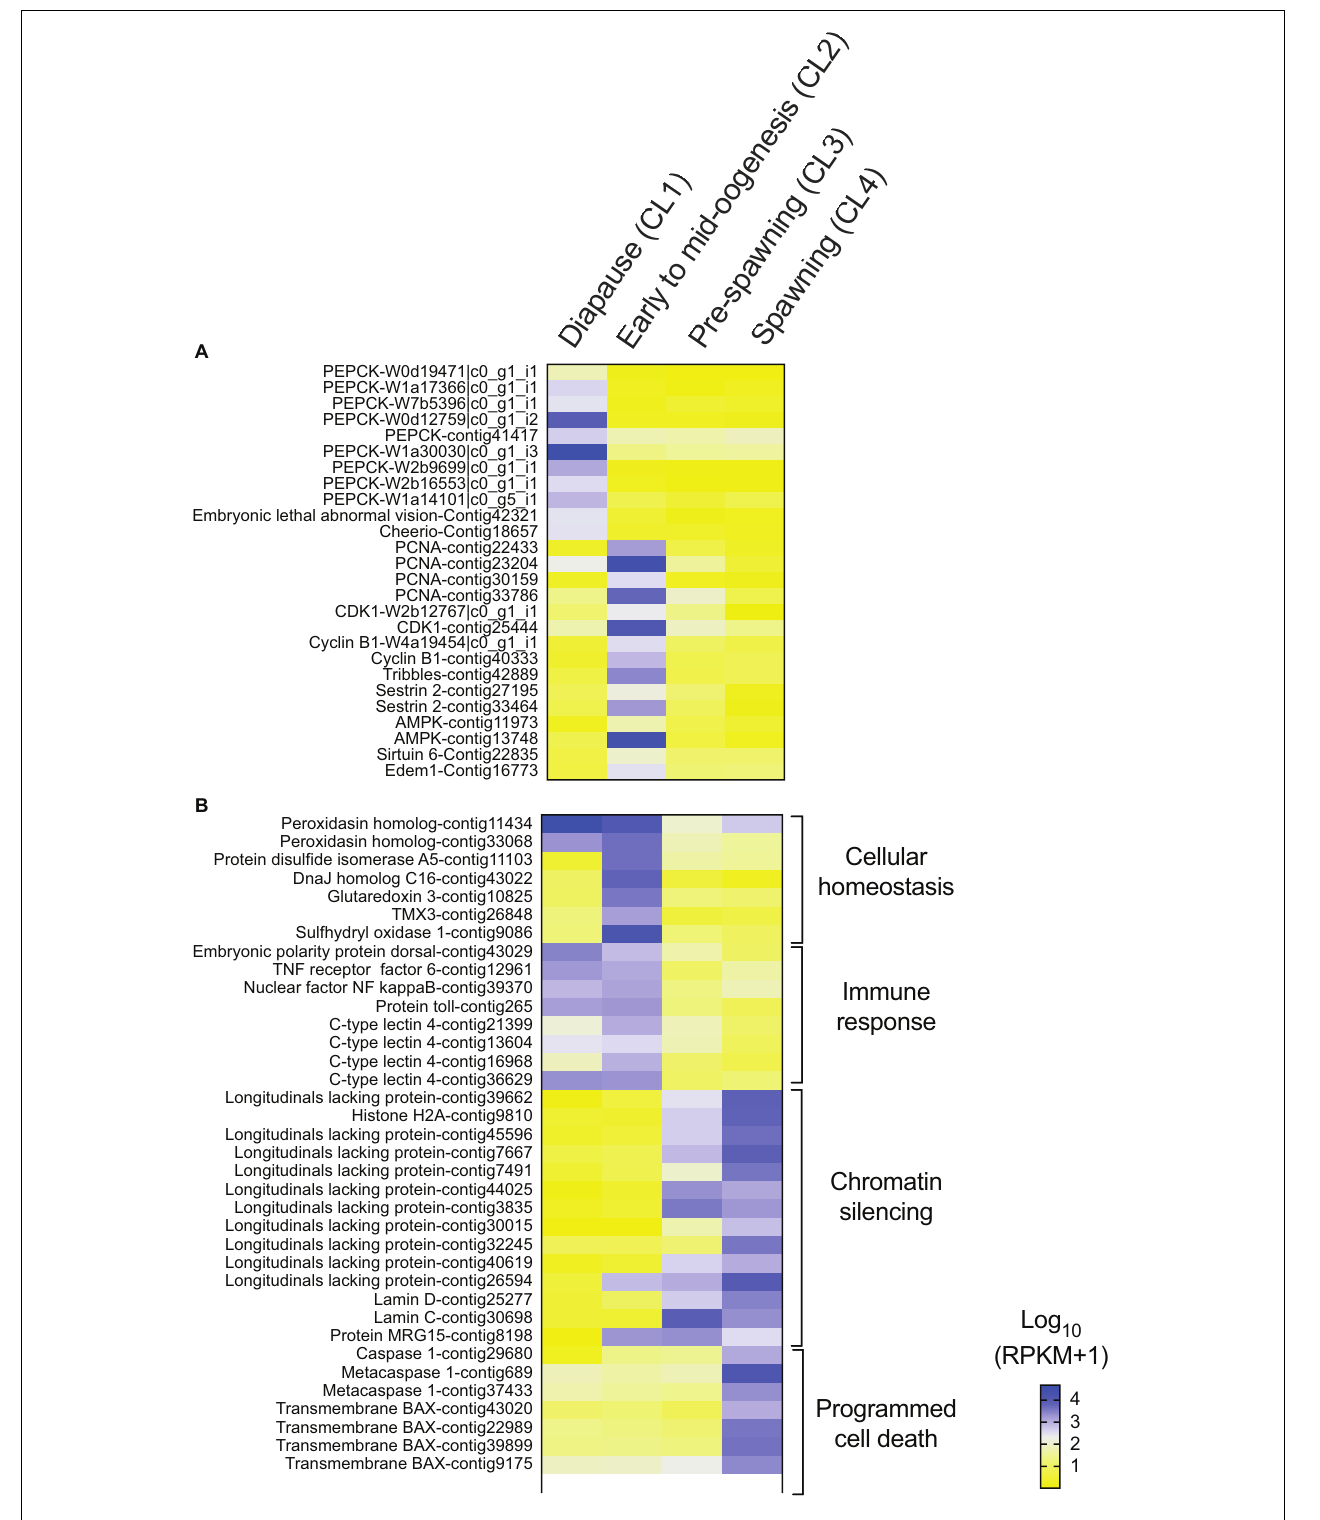
FIGURE 3 | Neocalanus flemingeri differential gene expression. Heat map of relative expression of target genes involved in (A) “diapause phenotype” and (B) “cellular homeostasis” [GO:0019725], “immune response” [GO:0006955], “chromatin silencing” [GO:0006342] and “programmed cell death” [GO:0012501]. Color-coding for each gene indicates the magnitude of expression as Log 10 (RPKM + 1). Columns are ordered by clusters following the grouping in Figure 1 as indicated by the labels (top). Genes were ordered by functional category (right).